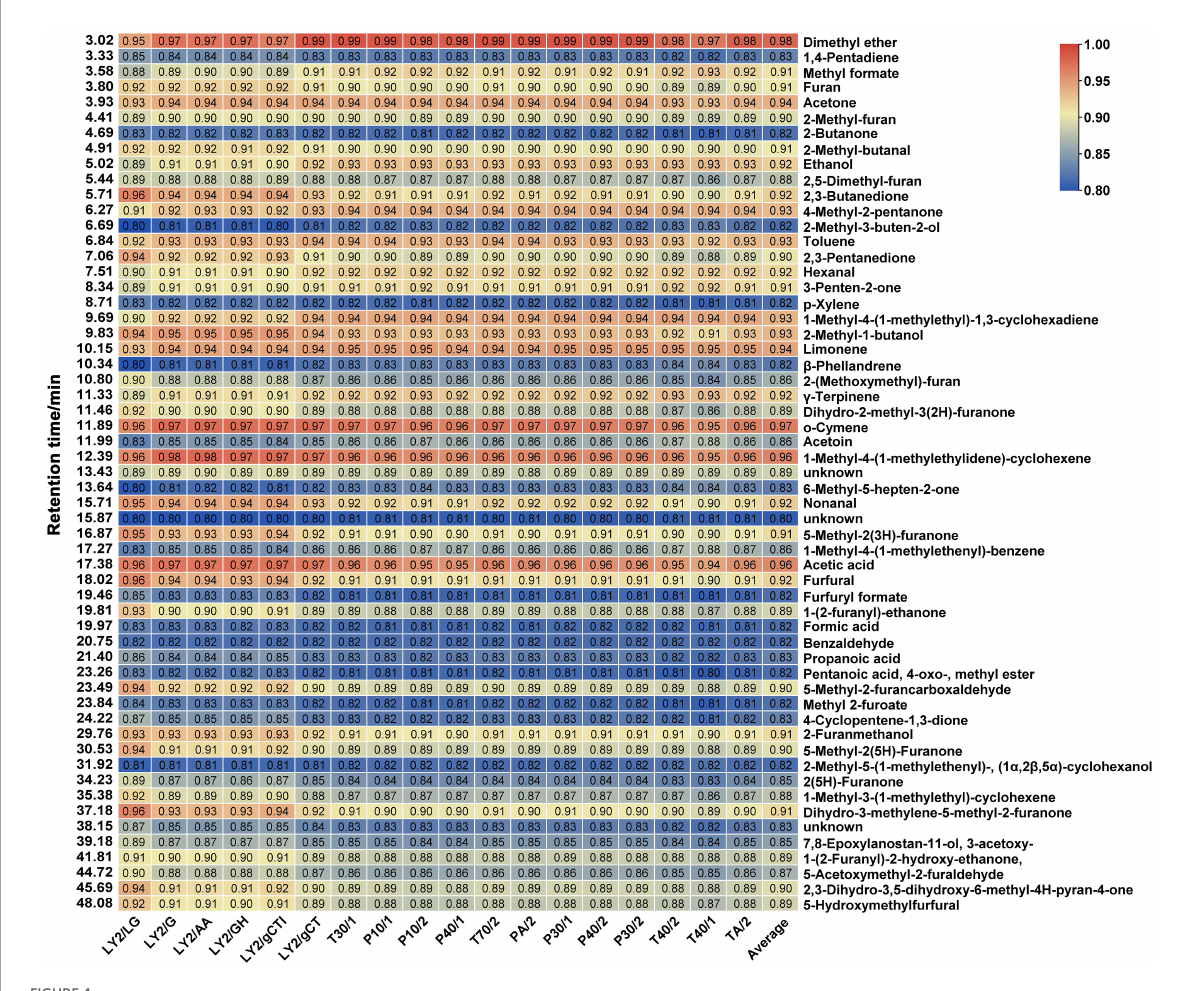
FIGURE4 Heatmap of sensor response and volatile components based on grey relational analysis. GRA, a method to evaluate the correlation between two variables based on their change curves geometric shape similarity, is suitable for analyzing dynamically changing variables. Each row in the figure represents a volatile compound, and each column represents an E-nose sensor. The data values in the square represent the correlation degree. Red represents the correlation degree higher than 0.9 while blue represents the correlation degree lower than